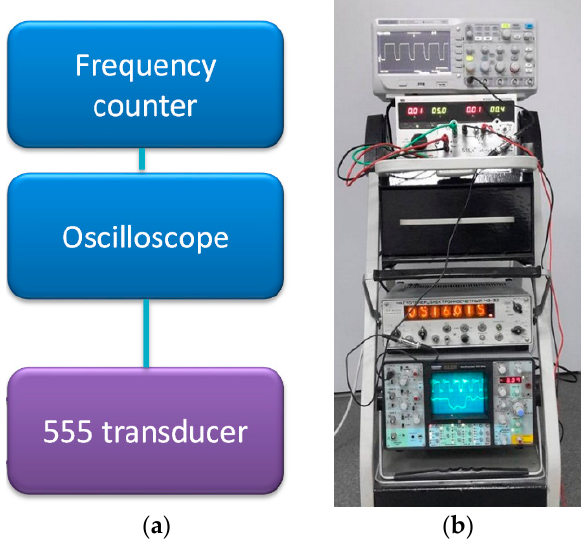
Figure 3. ( a ) Schematic diagram of mobile measurement test stand for a 555-based transducer, utilized for various sensors calibration; ( b ) photograph of actual test stand with power supply and additional digital oscilloscope.